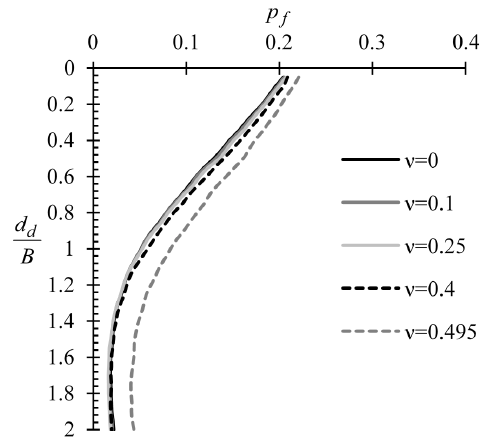
Figure 10. p f vs. d d / B example curves for θ / B = 10, x / B = 0 and di ff erent v values. Figure 10. f p versus example curves for θ /B = 10, x/B = 0 and different v values. d d B